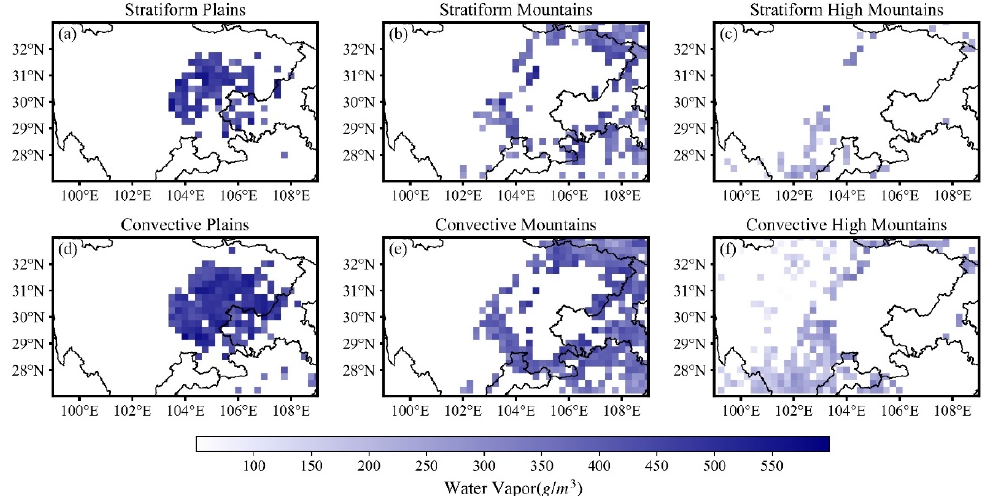
Figure 13. The horizontal Distribution of water vapor of two types of heavy precipitation over plains ( a , d ), mountains ( b , e ), and high mountains ( c , f ).